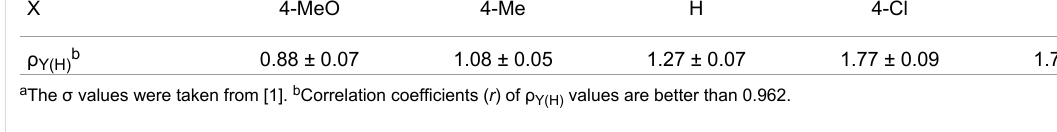
Table 3: Hammett coefficients ( ρ Y(H) ) a with Y for the reactions of Y-aryl phenyl isothiocyanophosphates with XC 6 H 4 NH 2 in MeCN at 55.0 °C. X